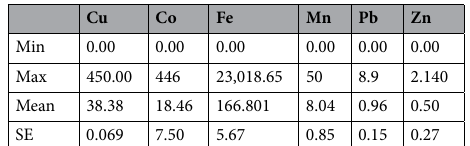
Table 5. Descriptive statistics of potential ecological risk index data in mine waste soil of Zambia.